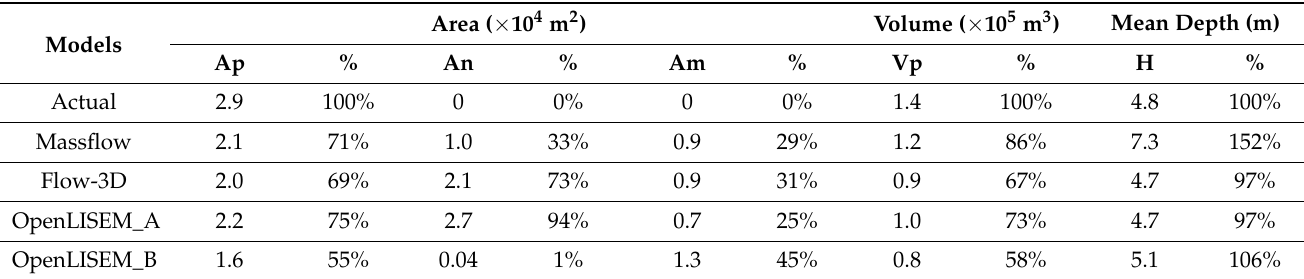
Table 4. Comparison of the simulation accuracy of four models. Ap means the positive accuracy area. An means the negative accuracy area. Am means the missing accuracy area. Vp means the positive accuracy volume. Mean depth means the mean depth of the debris fan.